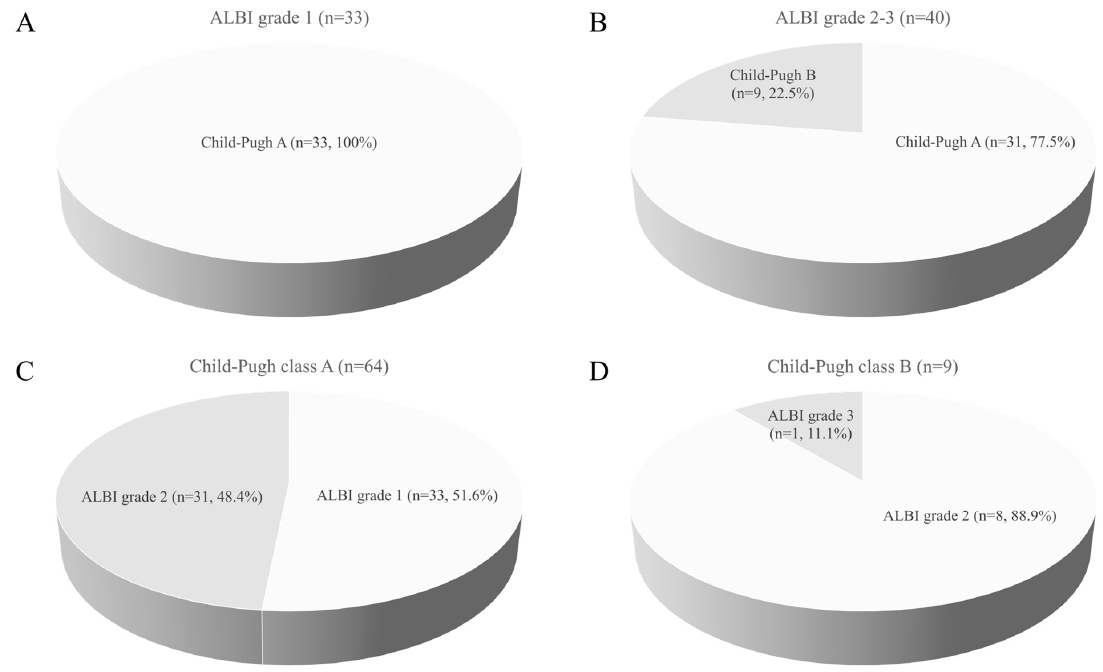
Figure 1. Pie charts show proportions of patients with regard to C–P class in ( A ) ALBI grade 1 patients and ( B ) ALBI grade 2–3 patients. Conversely, the portion of patients according to ALBI grades are shown within ( C ) C–P class A and ( D ) C–P class B. Even though ALBI grade 1 and C–P class B solely consisted of C–P class A and ALBI grade 2–3, respectively, the overlap of ALBI grade 2–3 and C–P class A was identified.